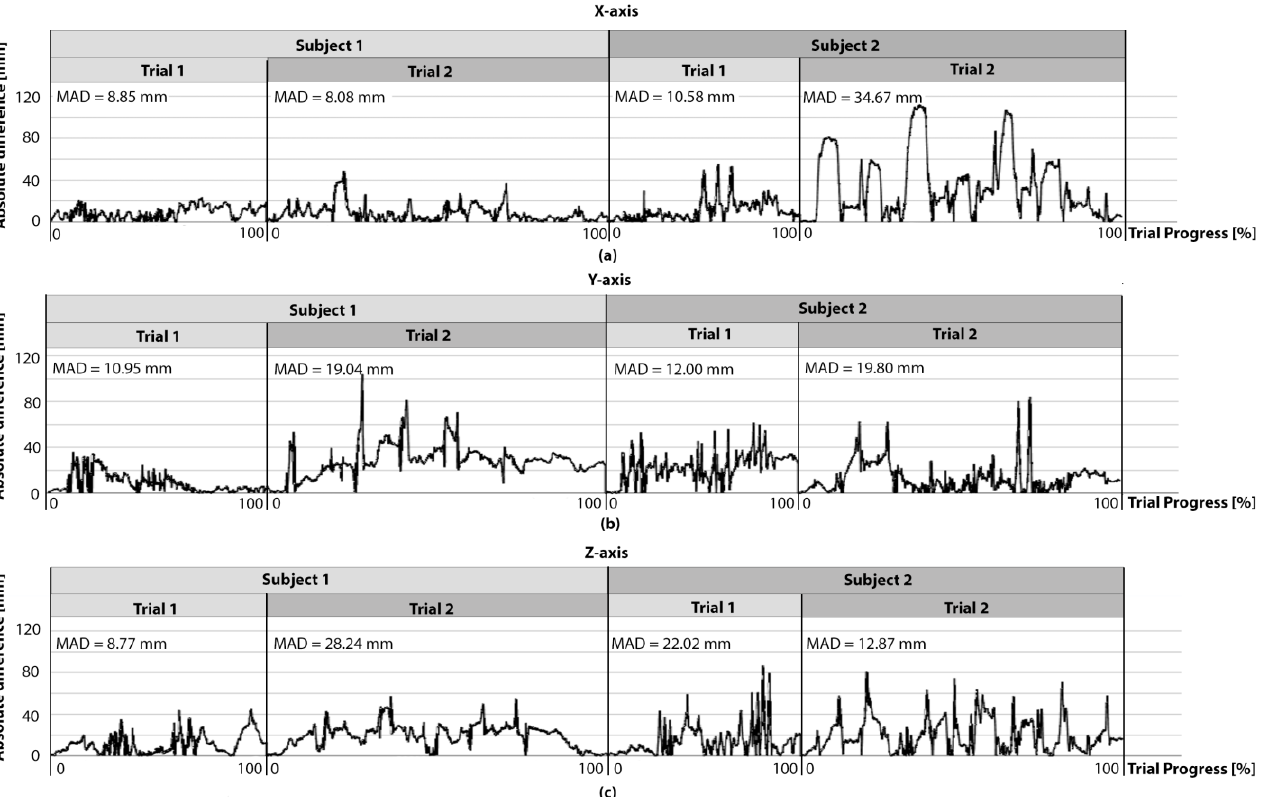
Figure 4. Plots of the absolute difference over time for the two trials of two representative subjects. The progress in one trial is shown as percentage of the duration. Therefore, 0% marks the start and 100% the end of the trial. For each trial the corresponding mean absolute difference (MAD) is shown. ( a ) Shows the absolute difference over time for the trials of two representative subjects along the sagittal axis. ( b ) Shows the absolute difference over time for the trials of two representative subjects along the transversal axis. ( c ) Shows the absolute difference over time for the trials of two representative subjects along the longitudinal axis.